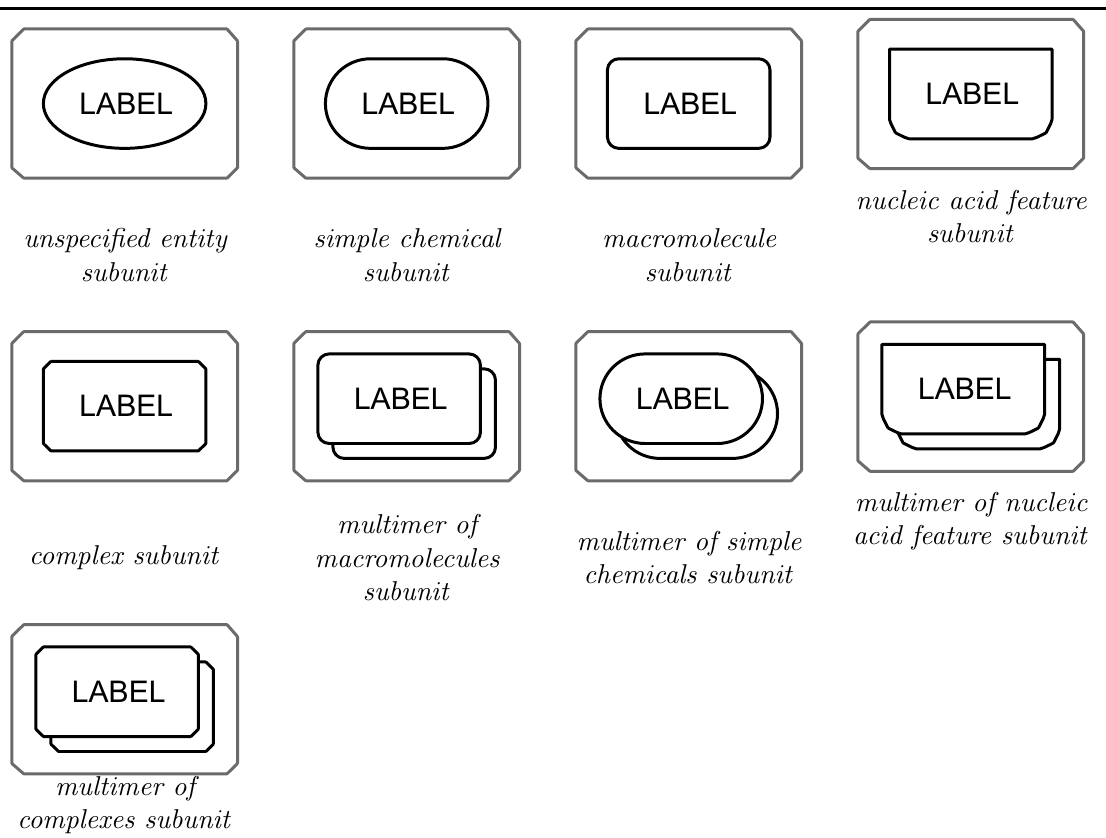
Table 2.7: The Process Description glyphs for the different types of subunits . Each subunit decorates a complex